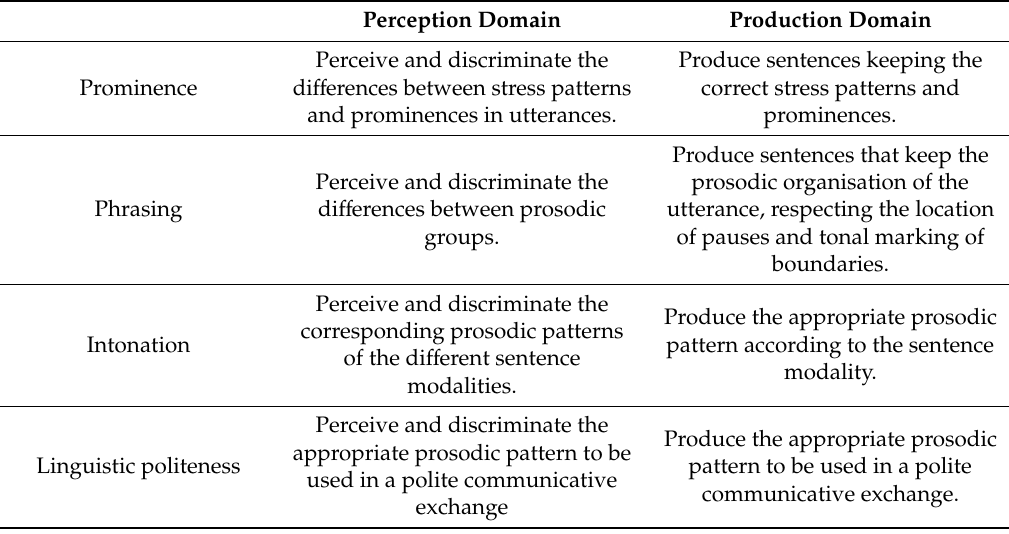
Table 2. Learning goals of the video